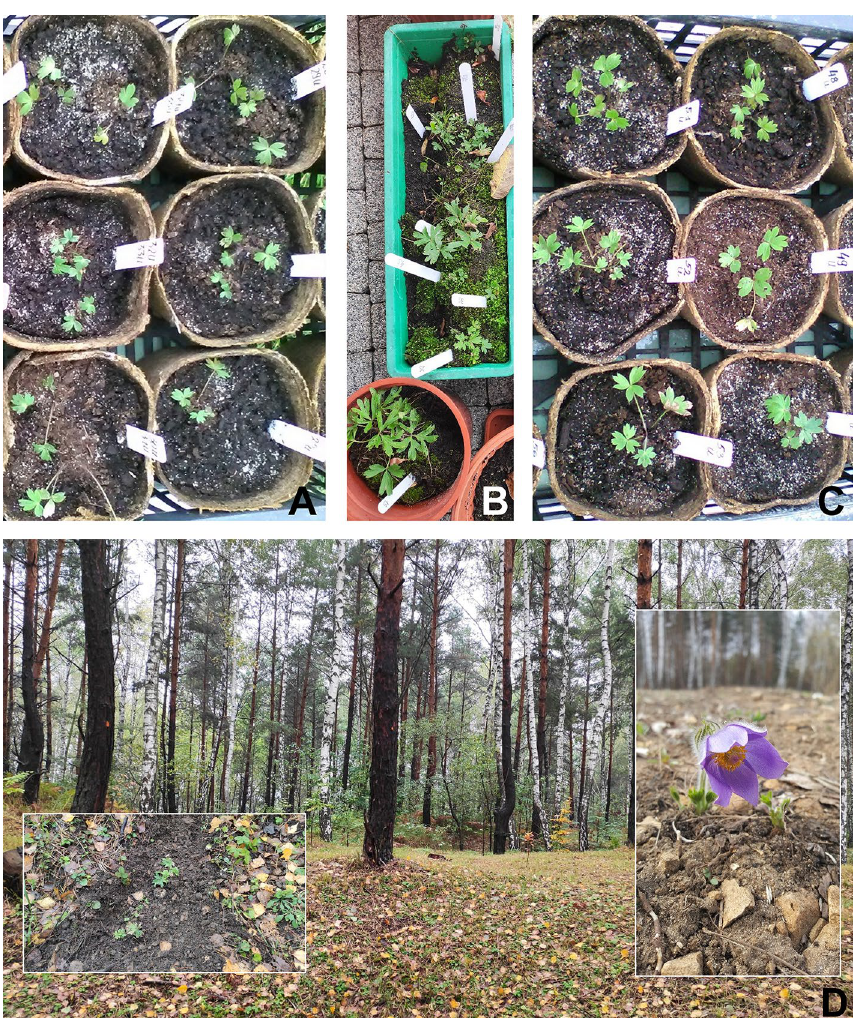
(Murashige & Skoog) + 2% saccharose ( A ) and in substrate: garden soil ( B ). ( C ) Plants regenerated in vitro via organogenesis or somatic embryogenesis. At these stages of the development plants ( A – C ) were transplanted on Sadowa Góra in Jaworzno in October 2020. ( D ) Sadowa Góra (Jaworzno), open area at the edge of the forest; on the left transplanted plants in 2020 (inserted), on the right flowering plant in April